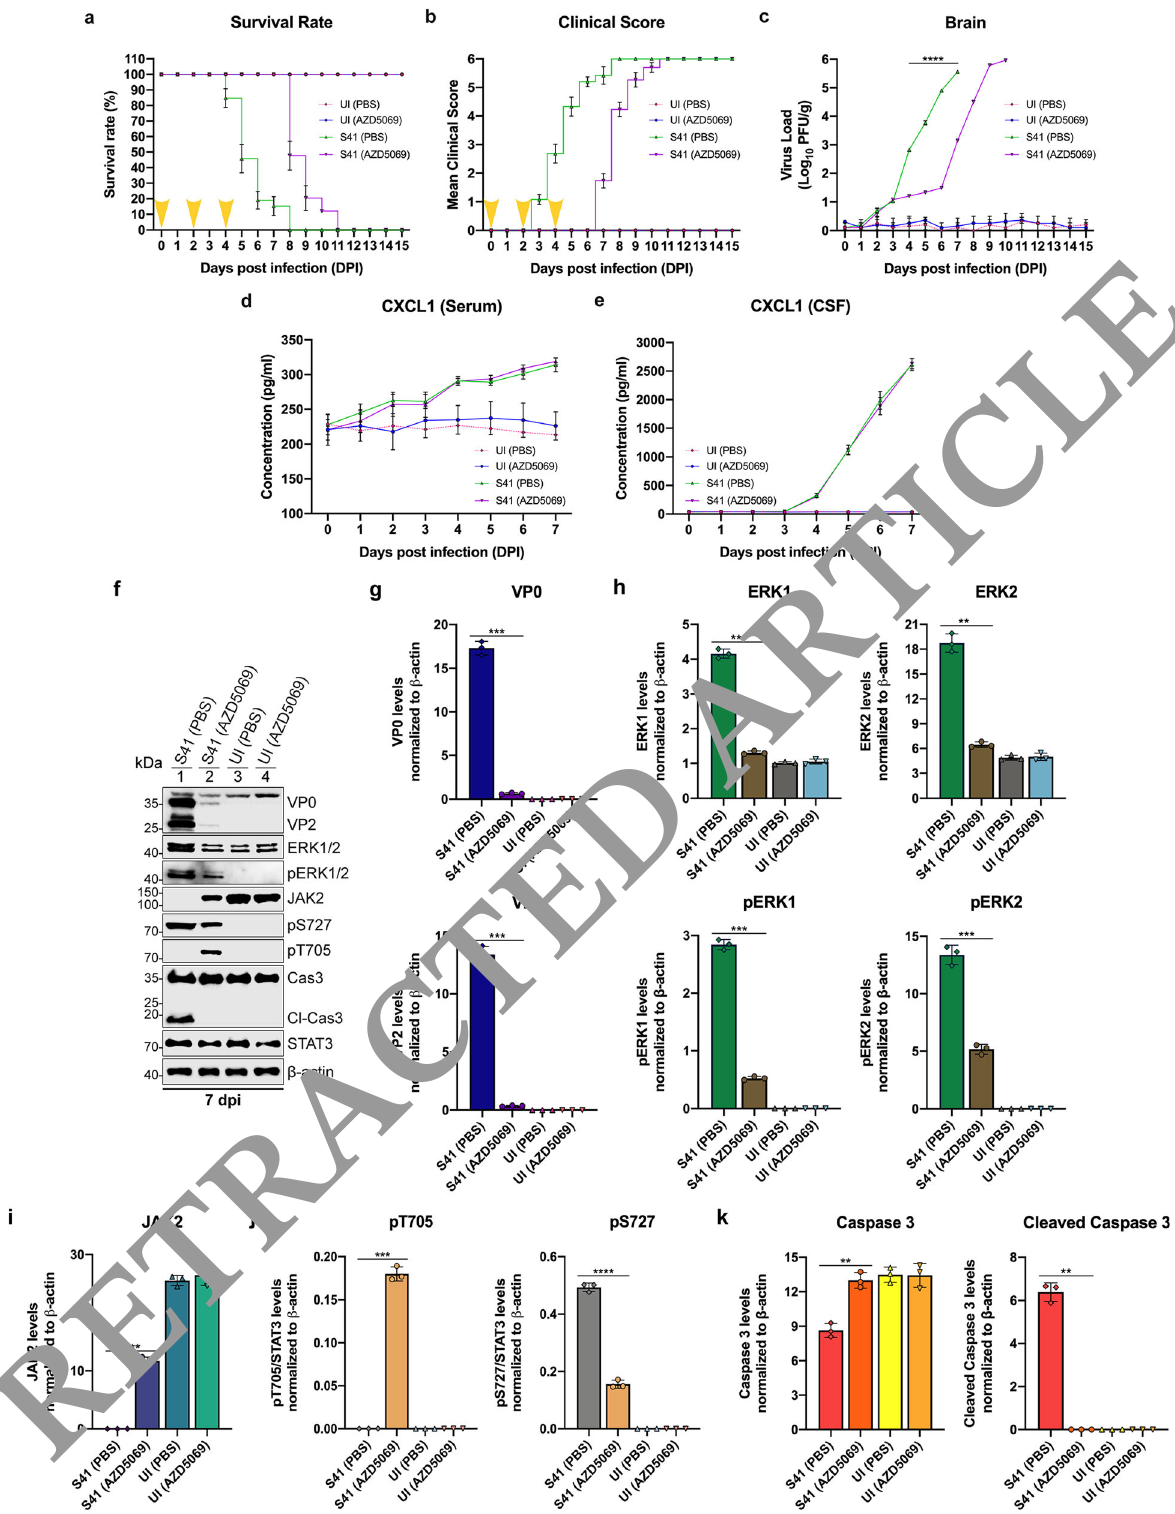
died at early timepoints due to S41 infection) and 7 dpi (if alive) and fi xed with 4% paraformaldehyde (PFA) for 1 week at 4°C. Sectioning of 80µm thick free fl oating coronal sections through the prefrontal cortex and hippocampus were performed using a vibratome (VR1200S, Leica). Sections were collected in cold PBS. Three consecutive sections through each region of interest were alternately stained using Nissl staining or with respective antigen-speci fi c antibodies. Nissl staining was used to evaluate neuronal cell death. Respective sections were mounted on gelatin-coated slides and dried at room temperature.